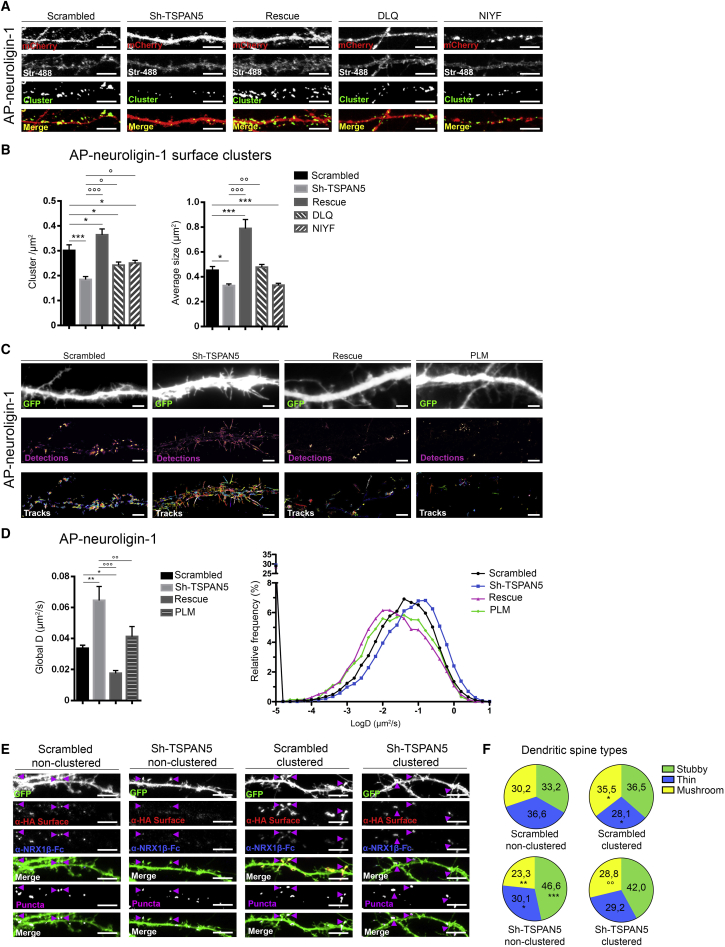
TSPAN5 Promotes NLG1 Clustering(A) Confocal images of dendrites from DIV 12 rat hippocampal cultured neurons transfected at DIV 5 with AP-NLG1, BirA-ER, and scrambled, Sh-TSPAN5, rescue, DLQ, or NIYF all co-expressing mCherry. Surface-applied Streptavidin-488 clusters shown in green. Scale bar, 5 μm.(B) Quantification of the cluster density (clusters/square micrometer) and average size (square micrometers) of Streptavidin-488 clusters. Scrambled, n = 19 neurons; Sh-TSPAN5, n = 20 neurons; rescue, n = 18 neurons; DLQ, n = 27 neurons; NIYF, n = 27 neurons.(C) Single-molecule tracking experiment with mStrav-647. Images of DIV 12 rat hippocampal cultured neurons transfected at DIV 5 with AP-NLG1, BirA-ER, and scrambled, Sh-TSPAN5, rescue, or PLM all co-expressing GFP. Top panels: widefield GFP signal of dendrites. Middle panels (intensity): super-resolved mStrav-647 detection maps as an intensity scale. Bottom panels (tracks): mStrav-647 trajectories shown in pseudocolors. Scale bar, 2 μm.(D) Quantification of single-molecule tracking. Left panel: quantification of global diffusion coefficient (square micrometers per second). Right panel: logarithmic distribution plot of diffusion coefficients of scrambled- (black), Sh-TSPAN5- (blue), rescue- (purple), or PLM-transfected neurons (green). Scrambled, n = 16 neurons; Sh-TSPAN5, n = 17 neurons; rescue, n = 16 neurons; PLM, n = 12 neurons.(E) Confocal images of DIV 14 cultured rat hippocampal neurons transfected at DIV 5 with HA-tagged NLG1 and either GFP-expressing scrambled or Sh-TSPAN5 constructs. Neurons treated from DIV 12 to 14 with either non-clustered neurexin1β-Fc (left panels) or neurexin1β-Fc pre-clustered with an unlabeled α-Fc antibody (right panels). Surface-applied α-HA antibody shown in red; surface-applied Alexa 647-labeled α-Fc shown in blue. Purple arrowheads show mushroom spines positive for clusters.(F) Pie charts of the proportion of stubby, thin, or mushroom spines relative to (E).Exact values are shown in Table S1. See also Figures S4–S7. Graphs represent mean ± SEM. In (F), ∗p < 0.05, ∗∗p < 0.01, ∗∗∗p < 0.001 versus scrambled non-clustered; °p < 0.05, °p < 0.01, °p < 0.001 versus Sh-TSPAN5 non-clustered.